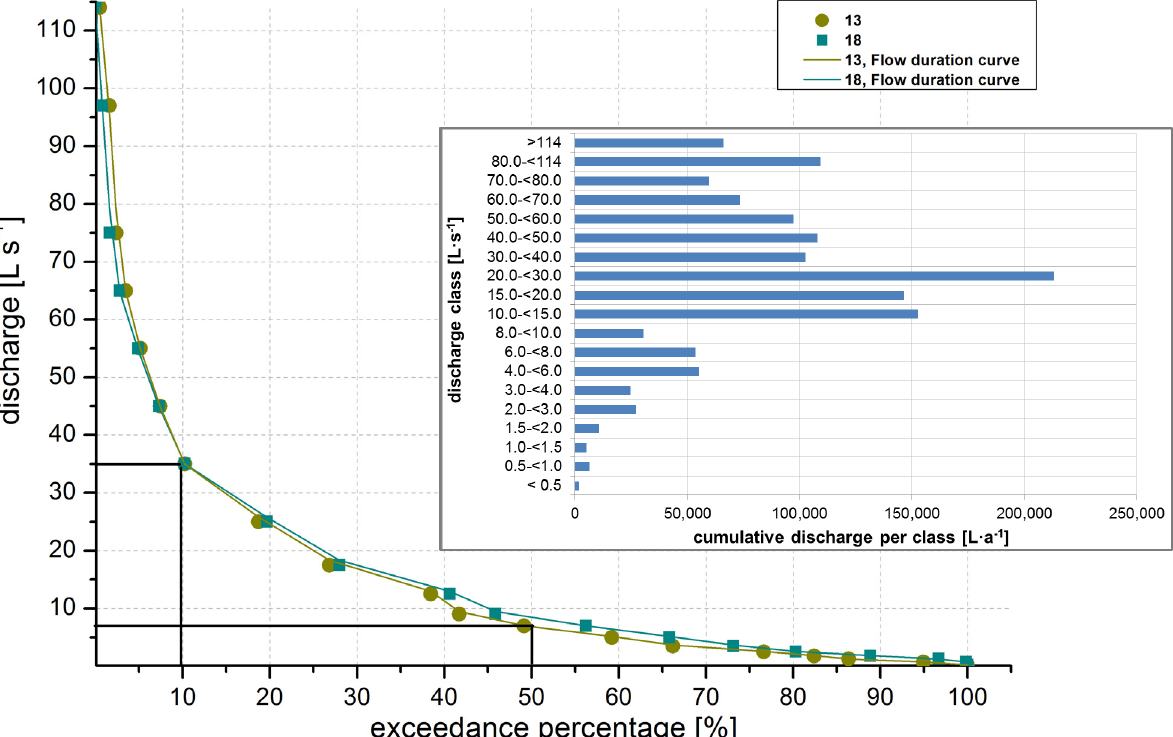
Figure 4. Flow duration curves for lower and upper RBC-flumes (13, 18) at the Vollnkirchener Bach (hydrological year 2012–2013). Insert exemplary shows classified cumulative discharge (L·s − 1 ) for lower